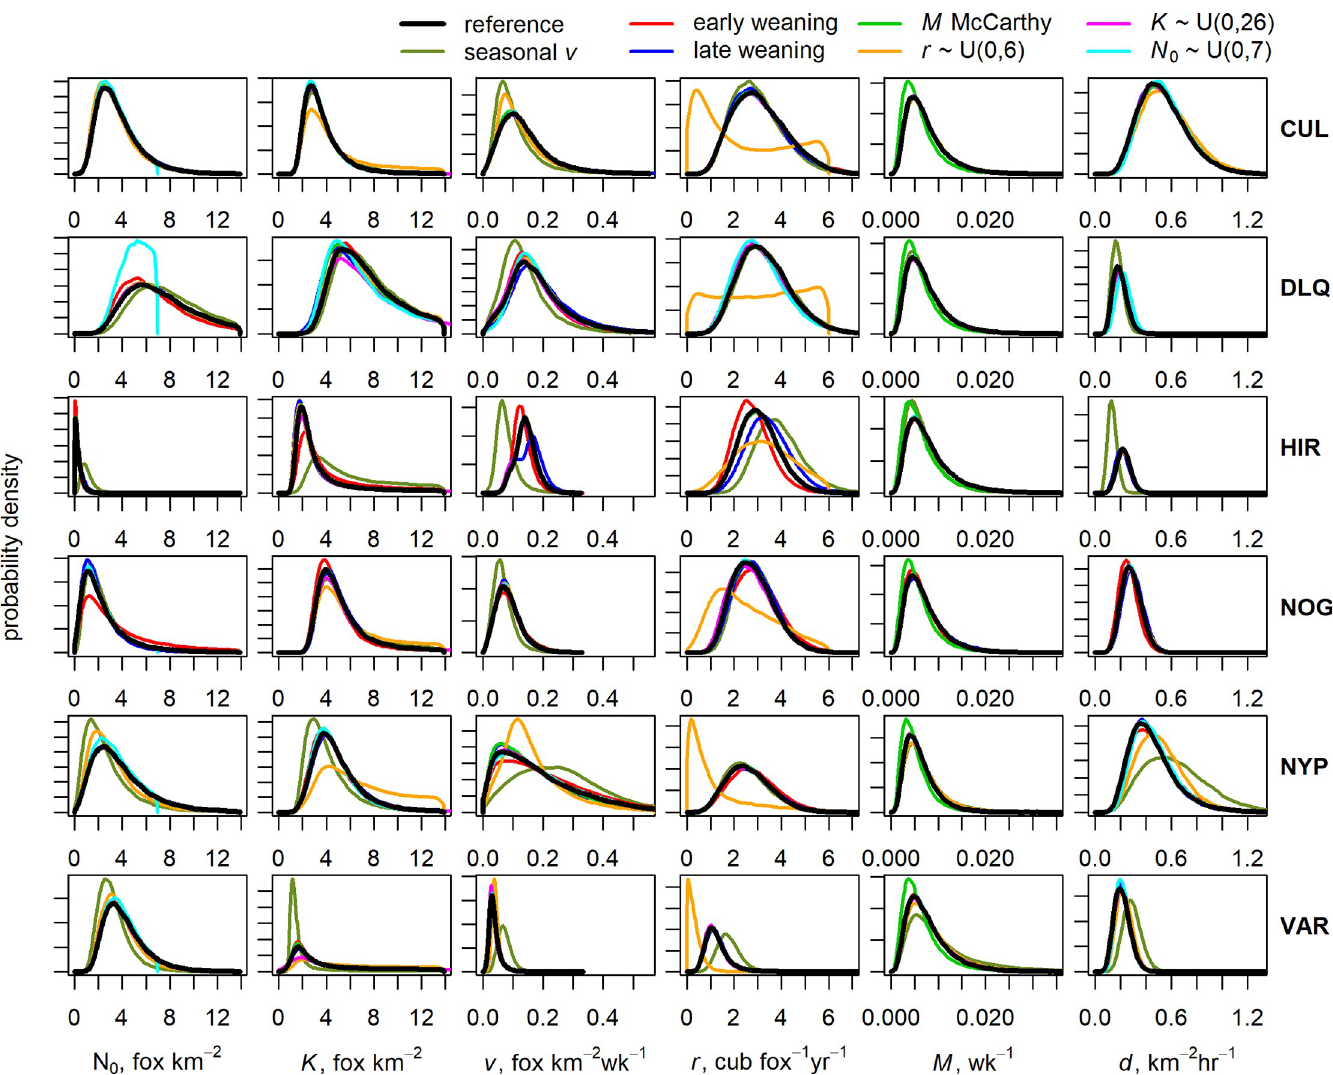
Fig 6. Sensitivity of marginal posterior distributions for parameters (columns) from six estates (rows) to different structural assumptions and prior distribution specifications. The reference case distributions shown are from the informative prior model. These are compared to the distributions obtained under assumptions about the seasonality of immigration and timing of cub recruitment, and specification of prior distributions for M , r , K and N 0 . The y-axes are not labelled for